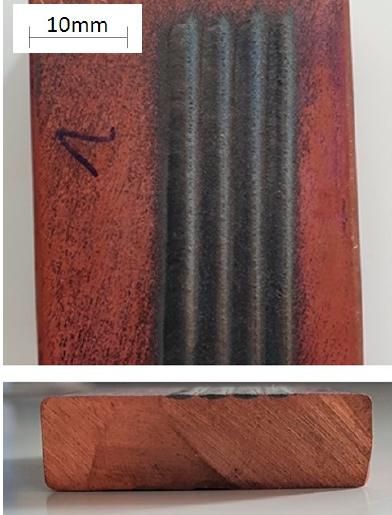
Figure 3. Sample of the melting’s surface and a cross-section before grinding with sandpaper. Table 1. Process parameters .